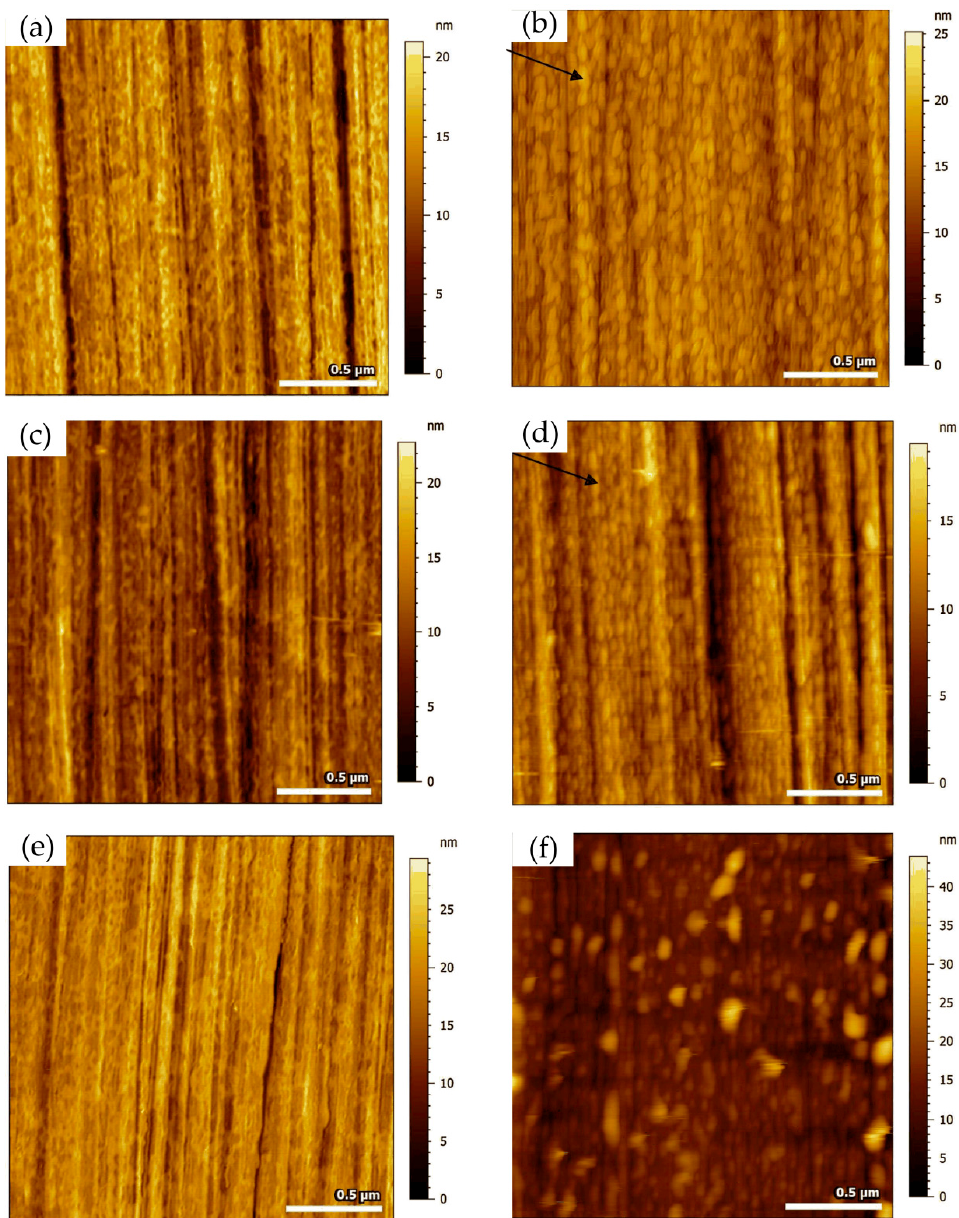
Figure 2. The AFM images of the steel specimen polarized at − 0.1 V (SCE—saturated calomel electrode) for ( a ) 0.5 min and ( b ) 60 min, at 0.5 V (SCE) for ( c ) 0.5 min and ( d ) 60 min, and at 0.7 V (SCE) for ( e ) 0.5 min and ( f ) 60 min. The black arrow points to scale-like spots. Adapted with permission from Reference [33];